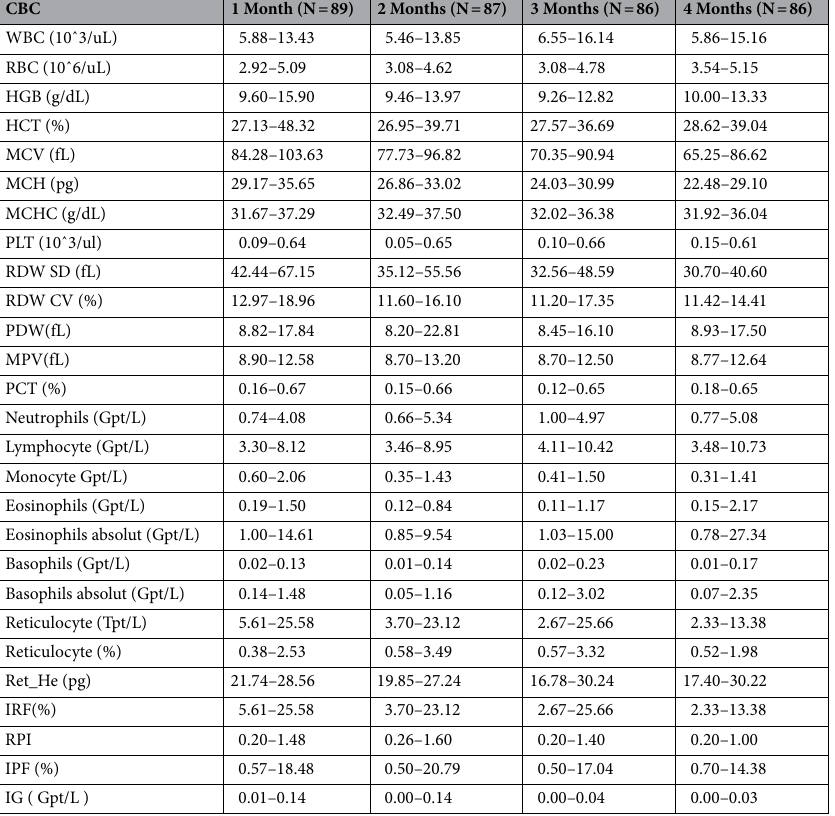
Table 2. P3-P97 of the white blood count, red blood cell count, hemoglobin, hematocrit, mean corpuscular volume, mean corpuscular hemoglobin, mean corpuscular hemoglobin concentration, platelet, red cell distribution with standard deviation, red cell distribution with coefficient of variation, platelet distribution with, mean platelets volume, plateletcrit, neutrophils, lymphocyte, monocyte, eosinophils, eosinophils absolute, basophils, basophils absolute, reticulocyte count, Ret-He, immature reticulocyte fraction, reticulocyte production index, immature platelet fraction, and immature granulocyte for healthy babies aged 1–4